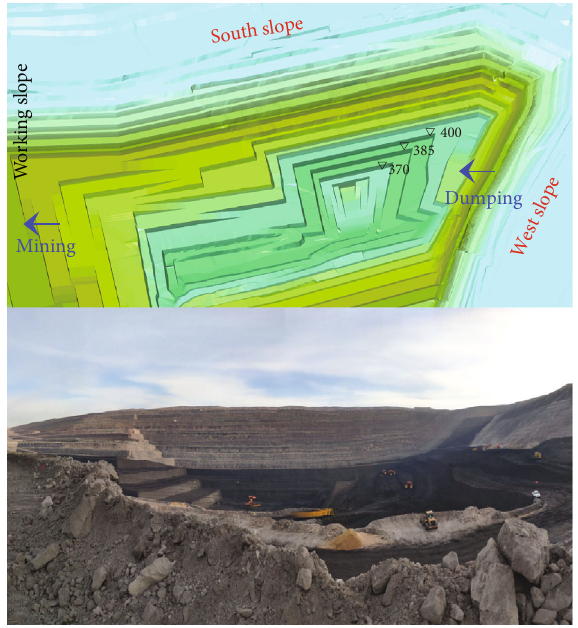
Figure 3: Overview and schematic diagram of the south slope